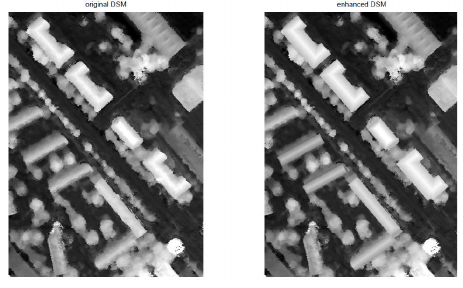
Figure 13: Merging LOD1 and